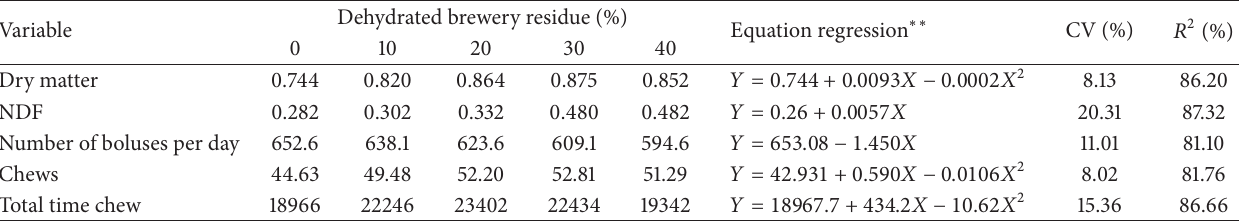
Table 2: Dry matter (kg/day) and neutral detergent fiber (NDF/kg/day) consumption in 24 hours, number of ruminated boluses per day (number of boluses per day), average time (sec) spent in chewing per bolus (boluses per sec), and total time chew (min/day) of ovine fed with marandu grass silage.